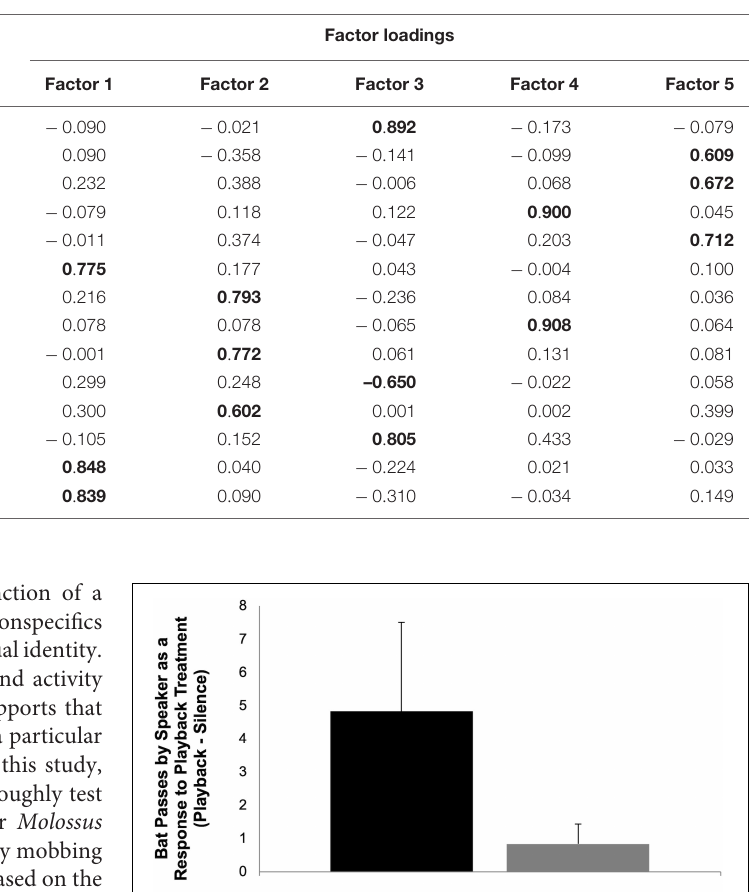
TABLE 1 | Descriptive statistics and varimax-rotated factor loadings for the acoustic variables measured from Brachyphylla nana distress call spectrograms.